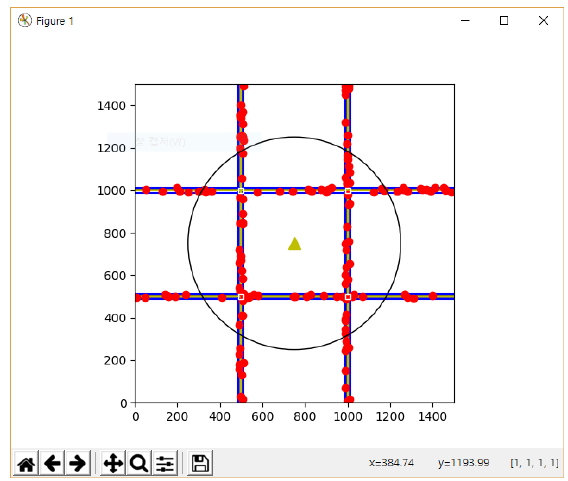
Figure 12. Simulation model.